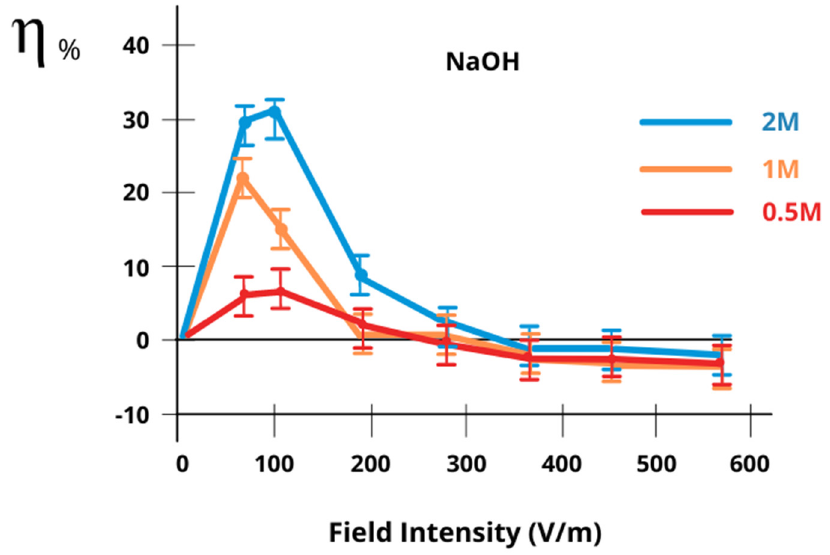
Figure 5. Percentage efficiency (cf. Equation (5)) against the strength in the case of the unit cm 2 photoanode; the static field was put across the front side (see Figure 4) [17,74].